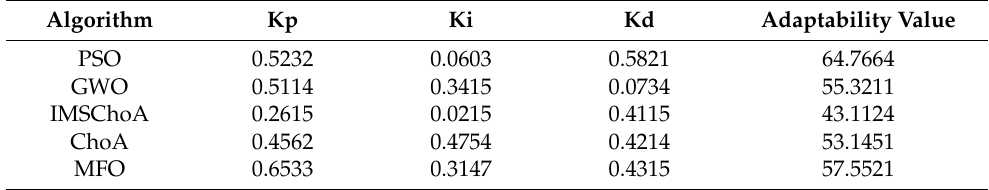
Table 5. The optimal solutions of each algorithm in the stretching/compression spring design problem.